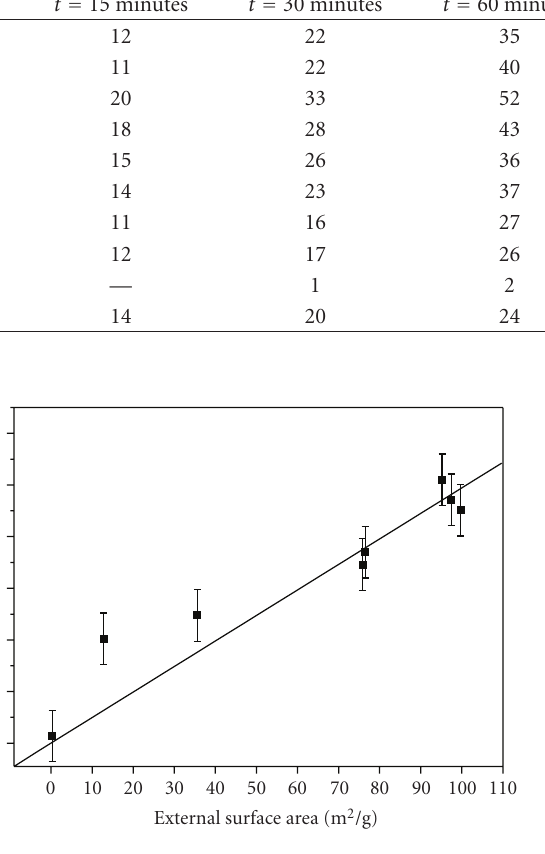
Table 1: Aldehyde conversion and photocatalytic activity (k a ) data obtained in the photo-oxidation with TiO 2 powders. Sample